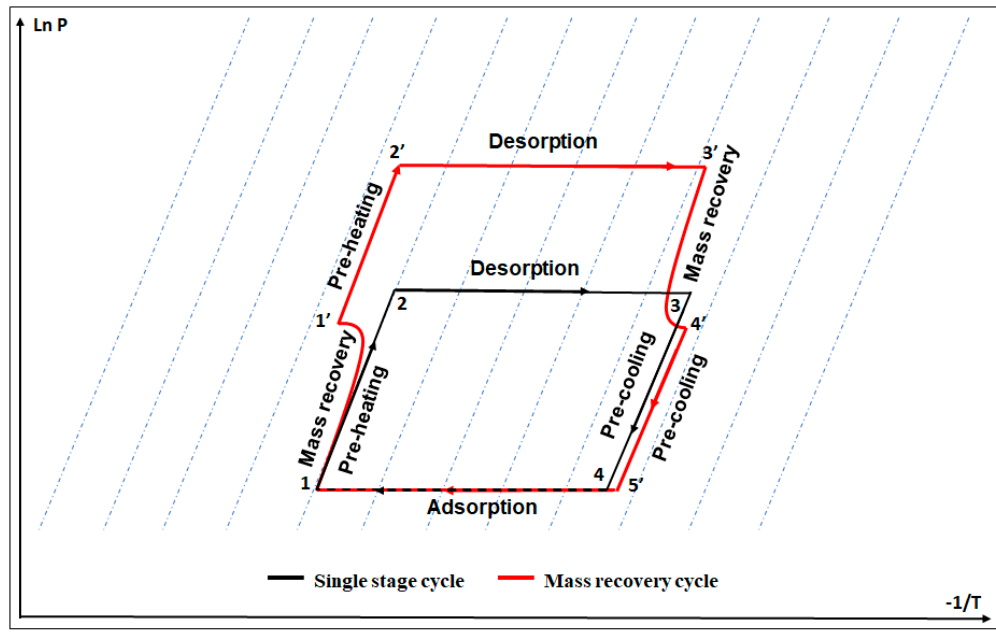
Figure 3. Clapeyron diagram of variable mode adsorption cooling cycle.